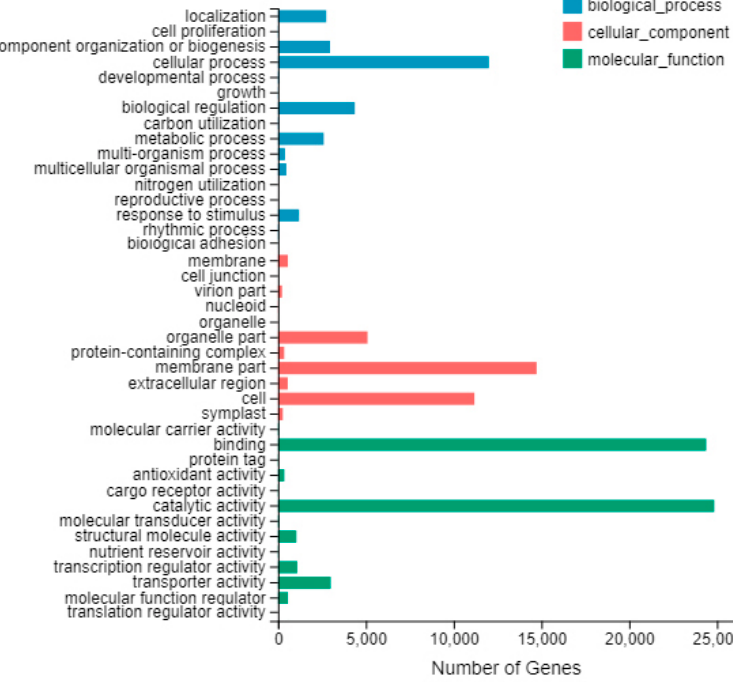
Figure 6. Gene ontology (GO) annotation of unigenes.